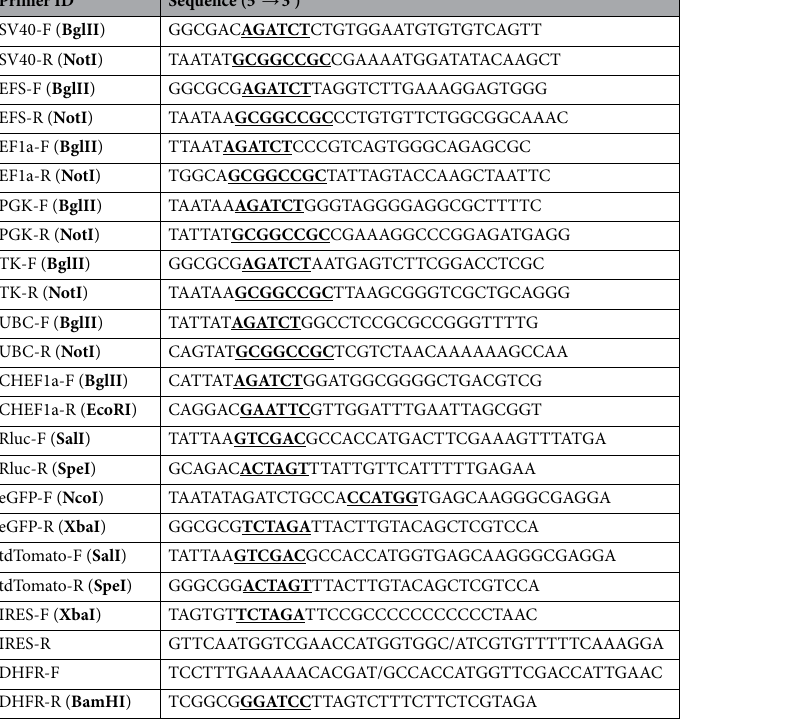
Table 1. List of oligonucleotides used in vector